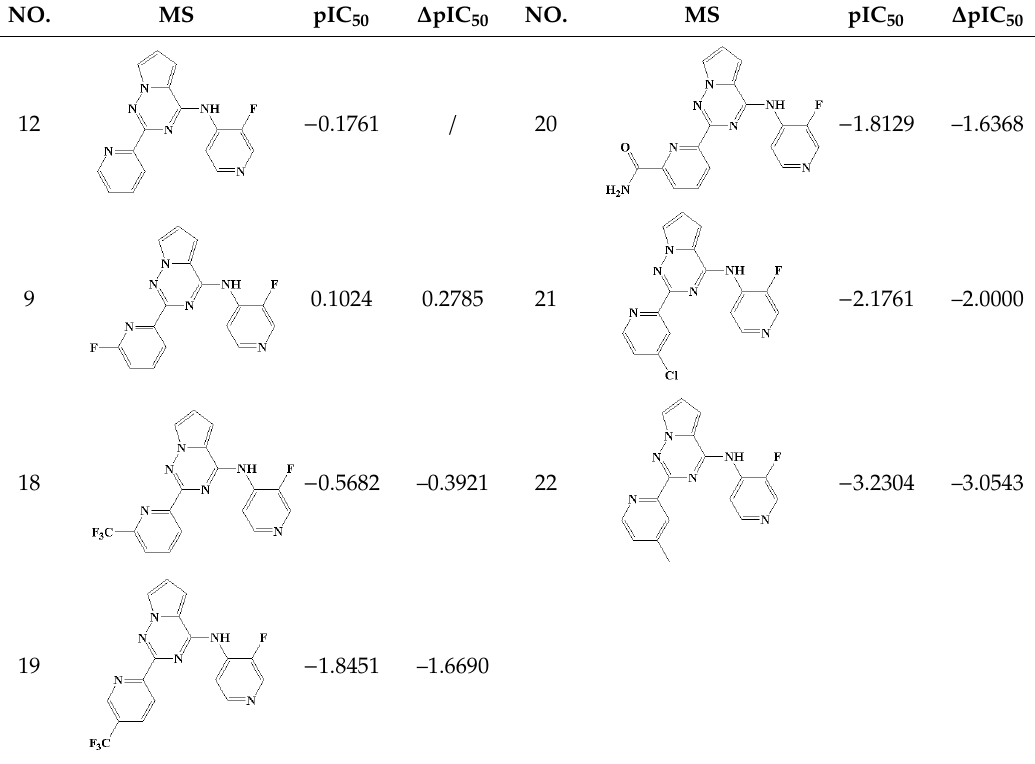
Figure 5. The binding modes of Compounds 7, 8, and 9 at the active site (amino acid residue SER280 in the Corey-Pauling-Koltun model, other amino acid residues in the line model and ligands in the stick model, among which Compound 7 is expressed in yellow; the receptor surface colored by the interpolated atomic charge—blue represents a positive value and red represents a negative value; the R2-position on ring A highlighted in a blue rectangle). Table 3. The structure-activity relationships on Ring B. Table 2. The structure-activity relationships in the R2-positon on Ring A.